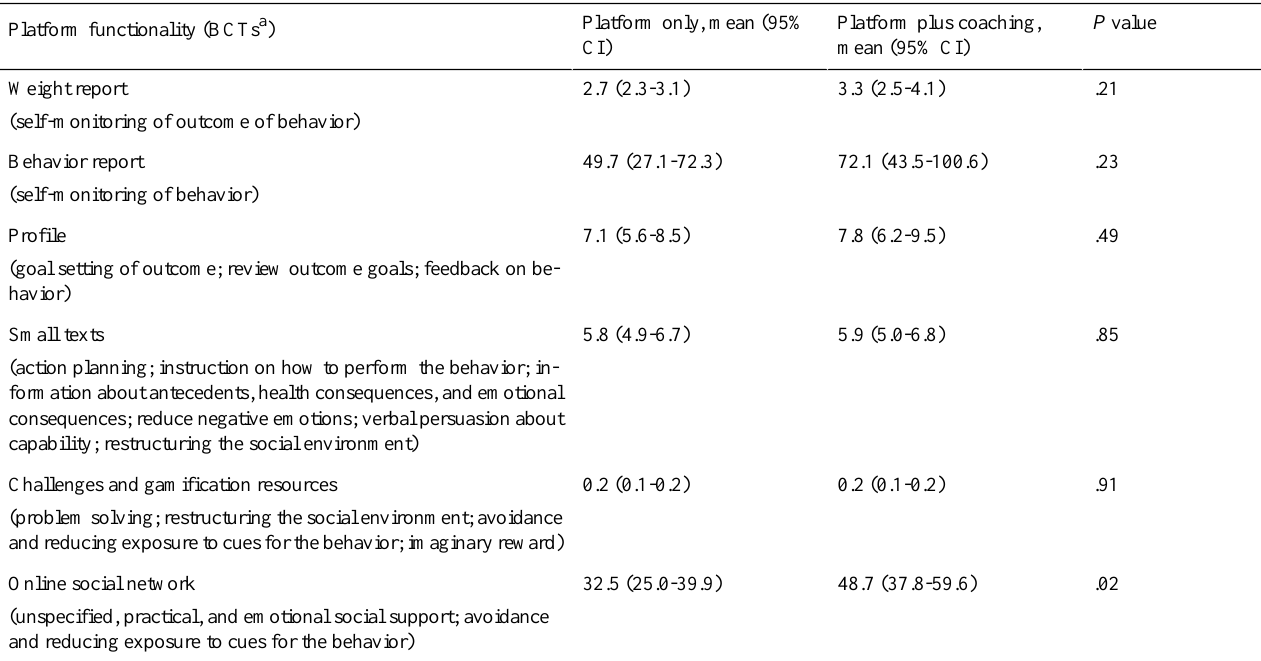
Table 4. Number of accesses to platform functionalities and the corresponding behavior change techniques between the platform-only and platform plus coaching